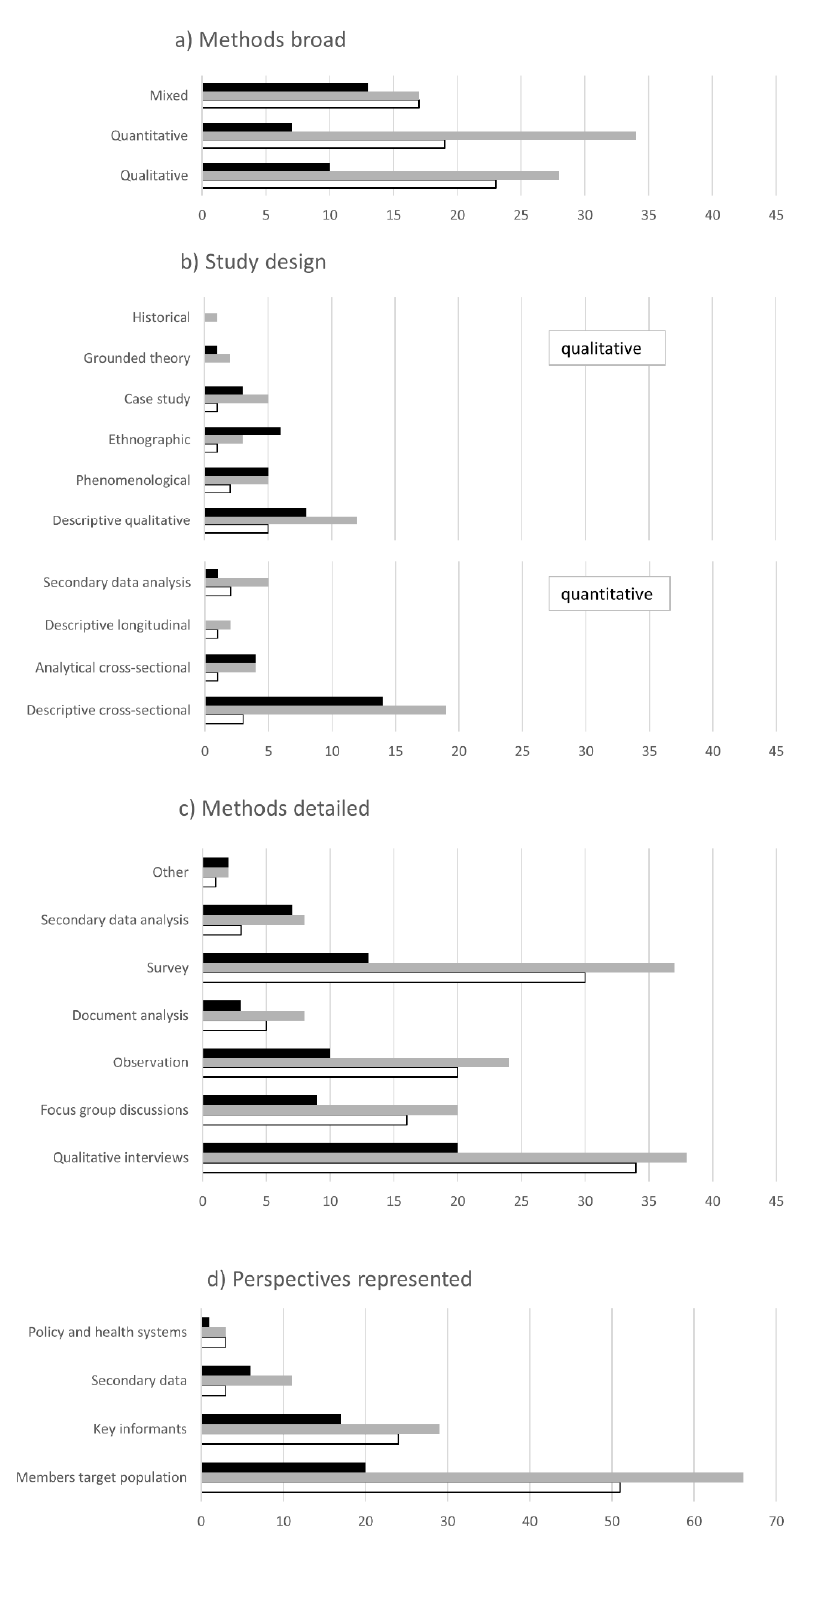
Figure 3. Charts of synthesised data items including ( a ) Methods broad, ( b ) Study design, ( c ) Methods detailed and ( d ) Perspectives represented. (Note: different scale than other diagrams). ( x -axis = number of articles, availability = black, accessibility = grey, acceptability =